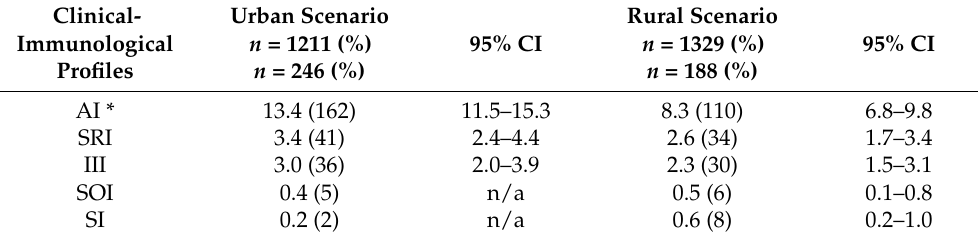
Table 1. Prevalence of the clinical-immunological profiles of human L. ( L. ) infantum chagasi -infections in distinct urban and rural epidemiological scenarios in Par á State, in the Brazilian